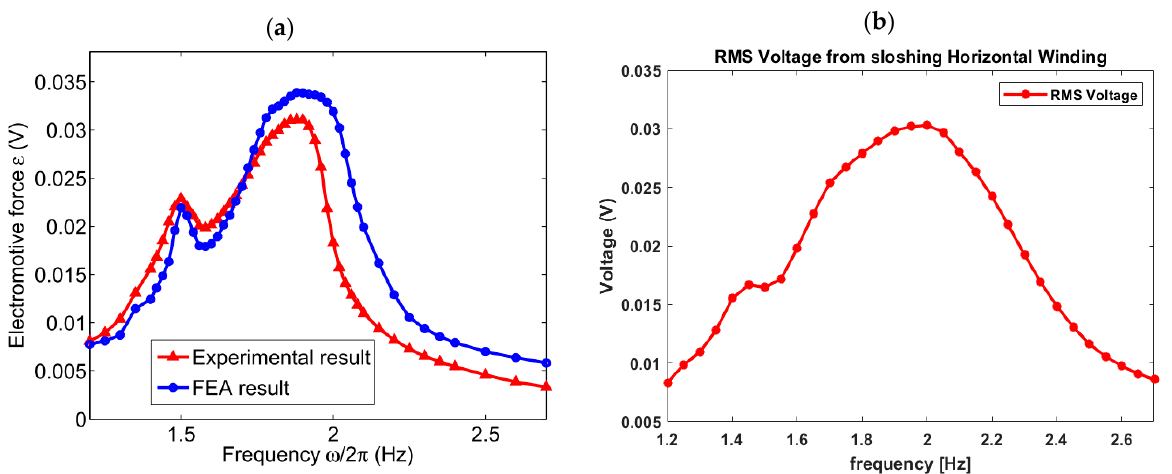
Figure 7. Comparison between ( a ) 1H configuration of Liu [44] and ( b ) present work. Table 2. Cases for Magnet